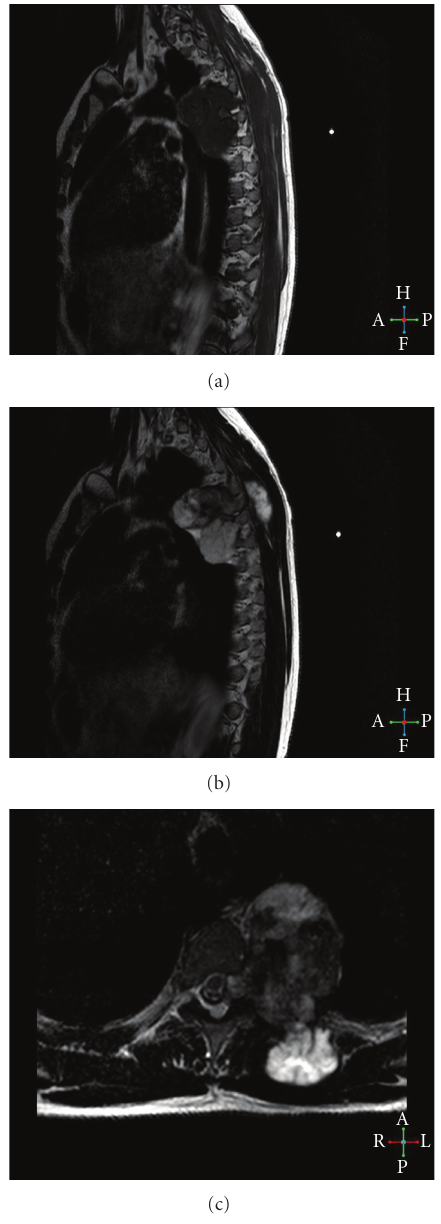
Figure 2: The sagittal T1-w (a) MR image shows a hypointense lobulated lesion. The mass demonstrates heterogeneous but pre- dominantly high signal intensity in the sagittalT2-w. (b) MR image. Note the superficial palpable component of the tumor. (c) The T2 axial view shows how the tumor is positioned next to the ventral structures and its relationship to the spinal